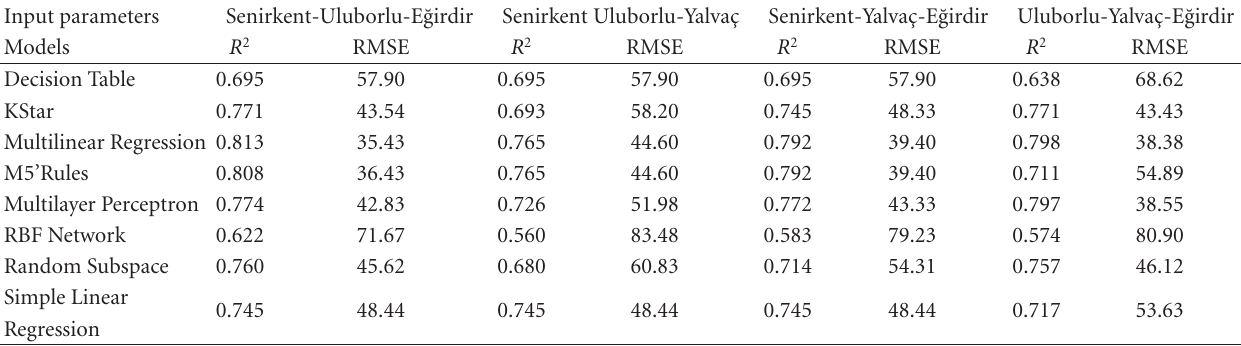
Table 3: The performance criteria of the models having 3-input parameters.